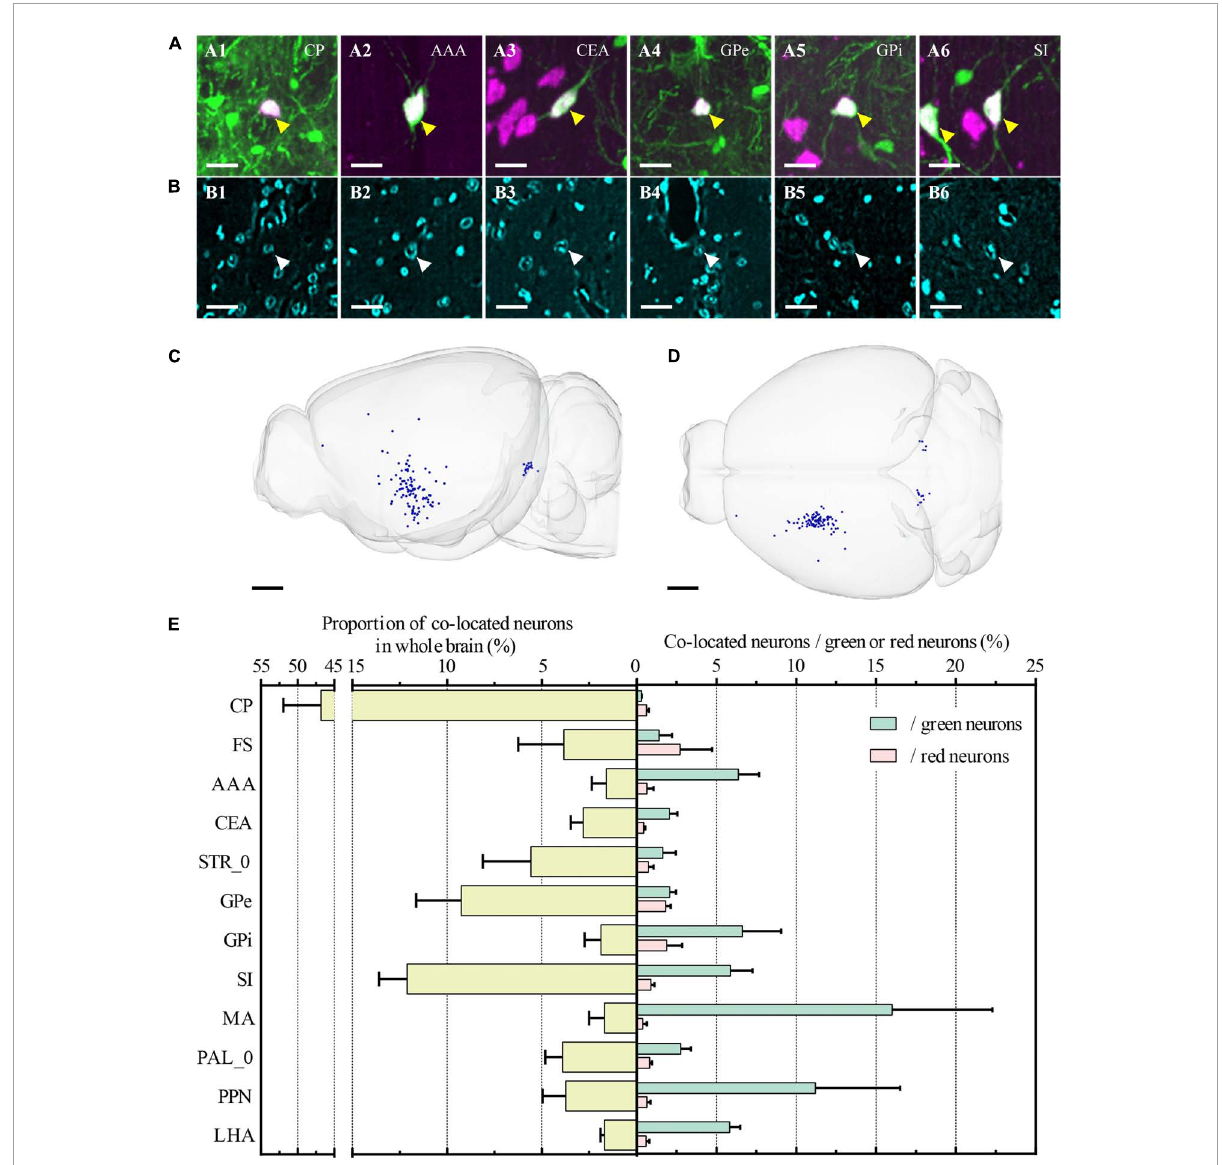
FIGURE7 Whole-brain quantitative statistics of co-located neurons between green and red channels. (A1–A6) Merged images of the co-located neurons at CP, AAA, CEA, GPe, GPi, and SI, respectively. Green and magenta represent signals in the green and red channels, respectively. The yellow arrows indicated the co-located neurons. (B1–B6) Images were acquired in the blue channel at the same region of interest in (A1–A5) . The white arrows indicated the nucleus of co-located neurons that were indicated in (A1–A5) . The projection thickness of the images: (A1–A6) 40 µ m and (B1–B6) 2 µ m. (C,D) Whole-brain distribution of co-located neurons in sagittal view (C) and horizontal view (D) . (E) The yellow histogram on the left showed the proportion of the co-located neurons in the main brain sub-regions, and the green and red histogram on the right showed the proportion of co-located neurons to the input neurons and the cholinergic neurons, respectively. Data is shown as mean ± s.e.m ( n = 4 mice). Scale bars: (A1–A6, B1–B6) 20 µ m and (C,D) 1 mm.